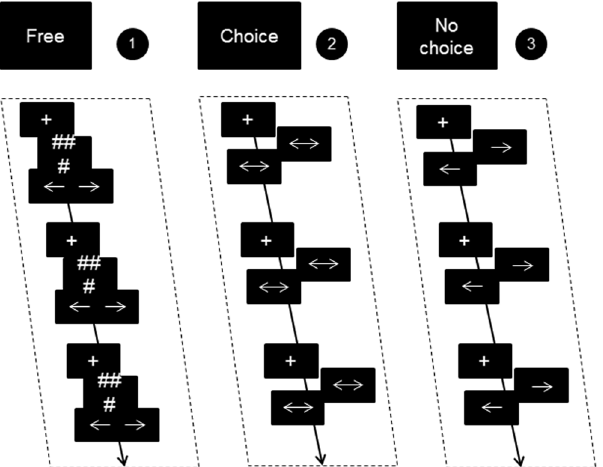
Figure 3. Outline of the Self-Initiative task with three conditions that were pseudorandomized in blocks (adapted from Hoffstaedter et al . 20